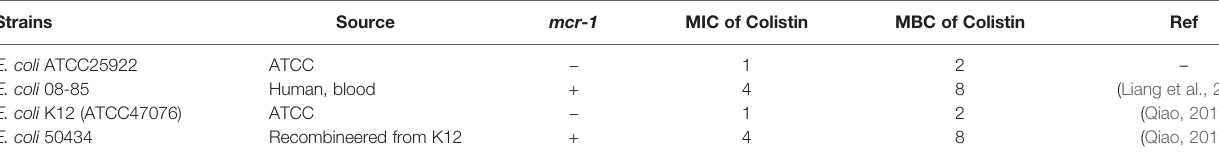
TABLE 1 | Strains used in this